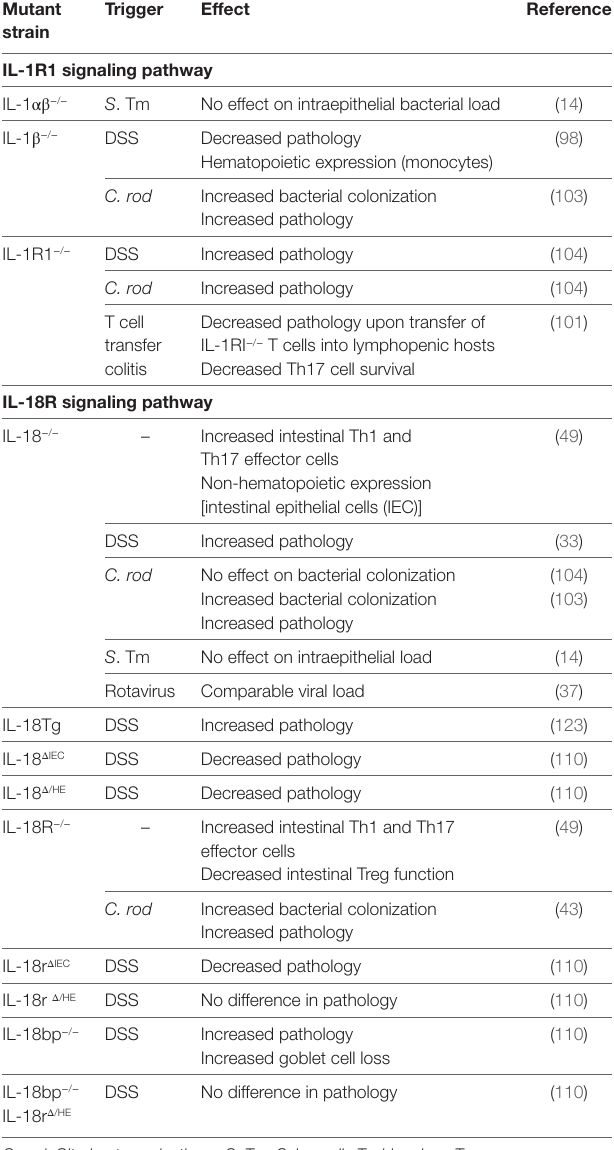
TabLe 3 | Soluble mediators of inflammasome activation and intestinal inflammation. Mutant